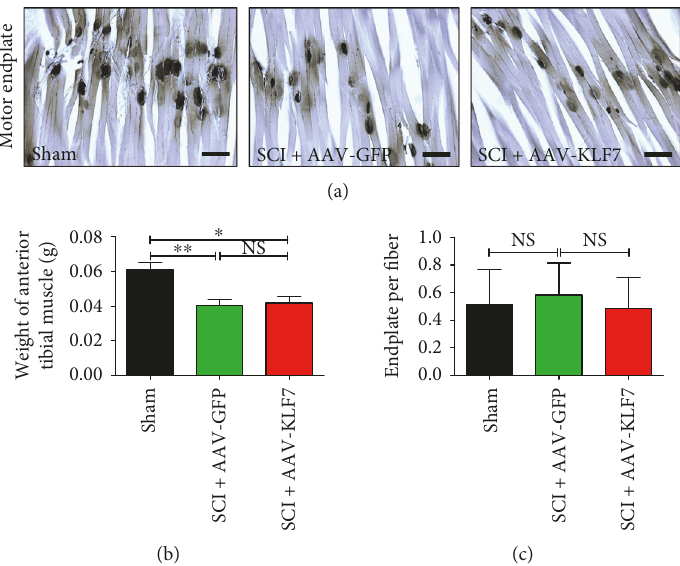
Figure 13: Weight of TA muscle and the number of motor endplate are una ff ected by KLF7 following SCI. (a) Acetylcholinesterase staining in sham, SCI + AAV-GFP, and SCI +AAV-KLF7 groups. Quantitative analyses of TA muscle weight (b) and the numbers of endplate per fi ber (c) ( n = 6 mice/group). Error bars show SD. ∗ P < 0 05 , ∗∗ P < 0 01 , one-way ANOVA, Tukey ’ s post hoc test. NS: not signi fi cant. Scale bars: 50 μ